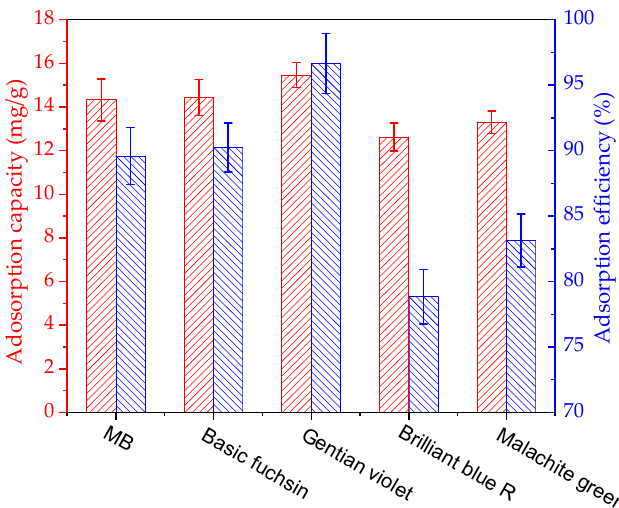
Figure 10. Adsorption capacity and efficiency of gelatin/ β -CD fiber adsorbents for different dyes.